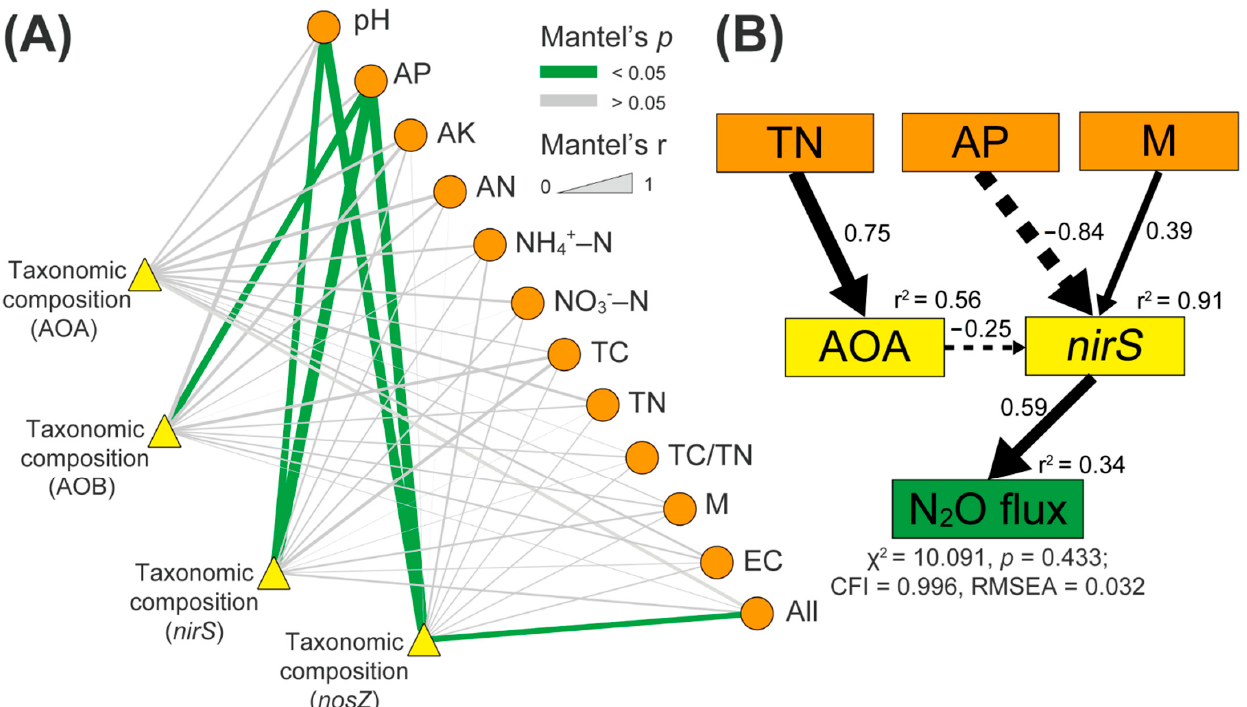
Figure 4. ( A ) Mantel test of relationships between the microbial community composition of AOA, ammonia-oxidizing bacteria (AOB), nirS -, and nosZ -carrying denitrifiers, and soil properties. Edge width is linked to the Mantel’s r statistic. AP: available P; AK: available K; AN: alkaline N; NH 4+ -N: ammonium-N; NO 3 − -N: nitrate-N; TC: total C; TN: total N; M: soil moisture; EC: soil electrical conductivity; All: all soil properties. AOA, AOB, nirS , and nosZ : ammonia-oxidizing archaea, bacteria, nirS-, and nosZ -carrying denitrifiers, respectively. ( B ) Structural equation model (SEM) analysis showed how soil factors and N-cycle microbial abundance affect soil N 2 O flux rates. AOA, nirS : the OTUs values of ammonia- oxidizing archaea, and nirS- carrying denitrifiers, respectively. Results of model fitting: chi-square = 10.091, p = 0.433 > 0.05, comparative fit index (CFI) = 0.996 > 0.95, root mean square errors of approximation (RMSEA) = 0.032 < 0.05. Solid and dashed arrows denote significant positive and negative effects ( p < 0.05), respectively. The r 2 values next to each parameter represent the variance explained by other parameters. The values upon each arrow indicate the standardized path coeffi- cients.